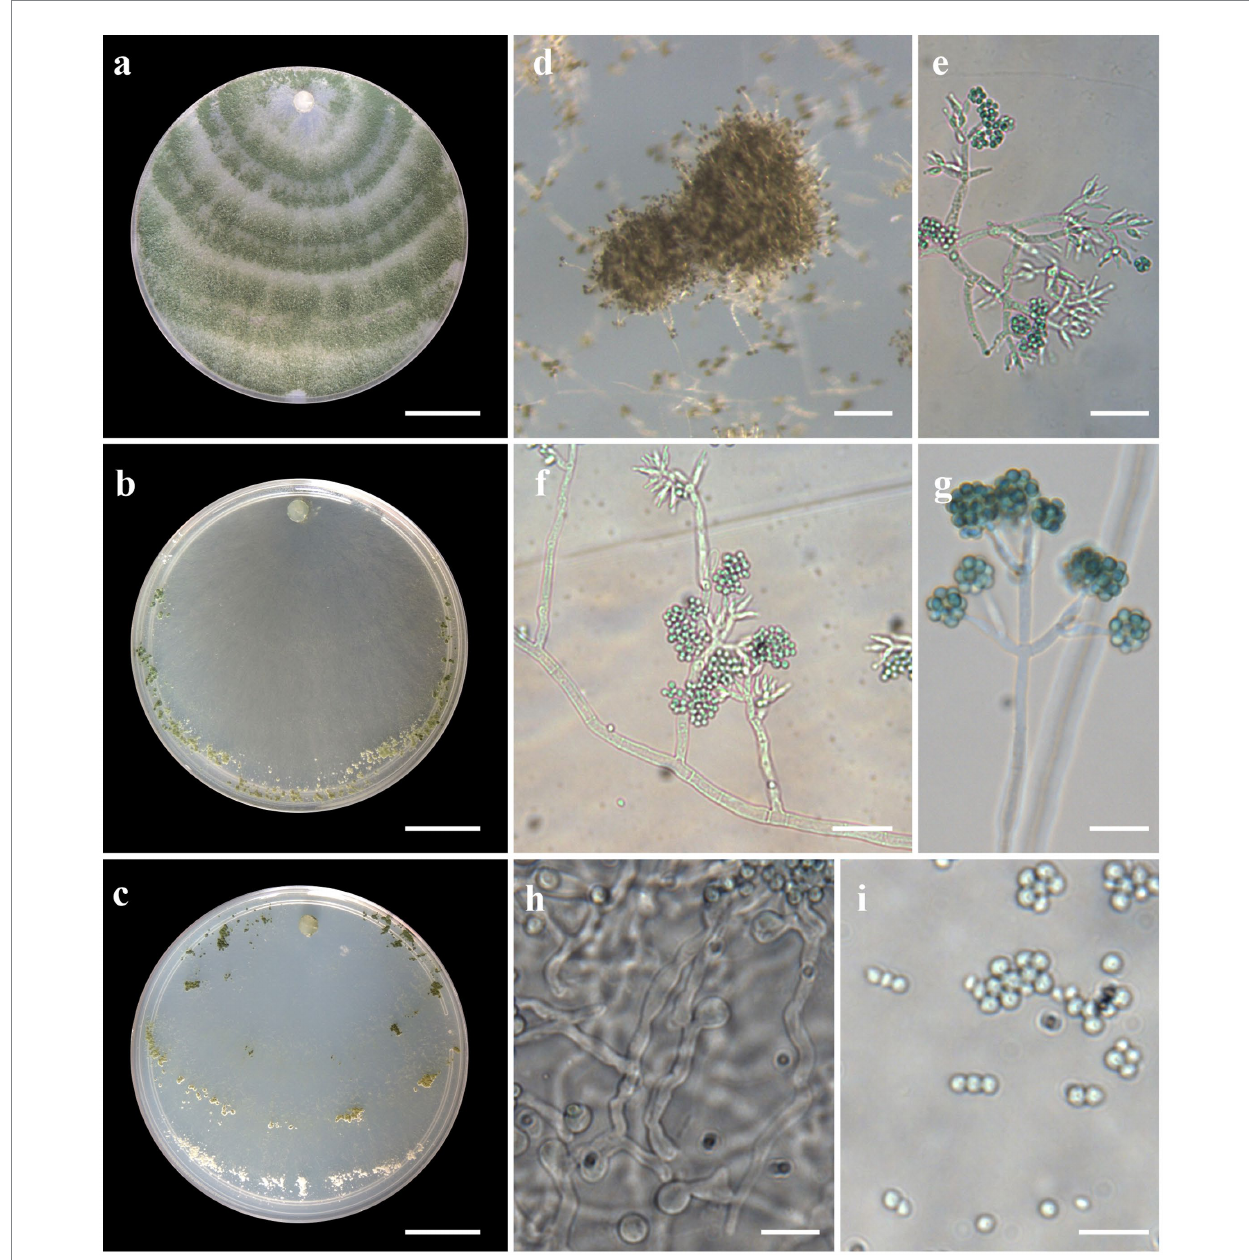
FIGURE 5 Asexual morph of Trichoderma brasiliensis sp. nov. from Hevea brasiliensis (VIC44363, holotype). ( A–C ) Colony appearances (PDA, CMD, and SNA; 7 days,